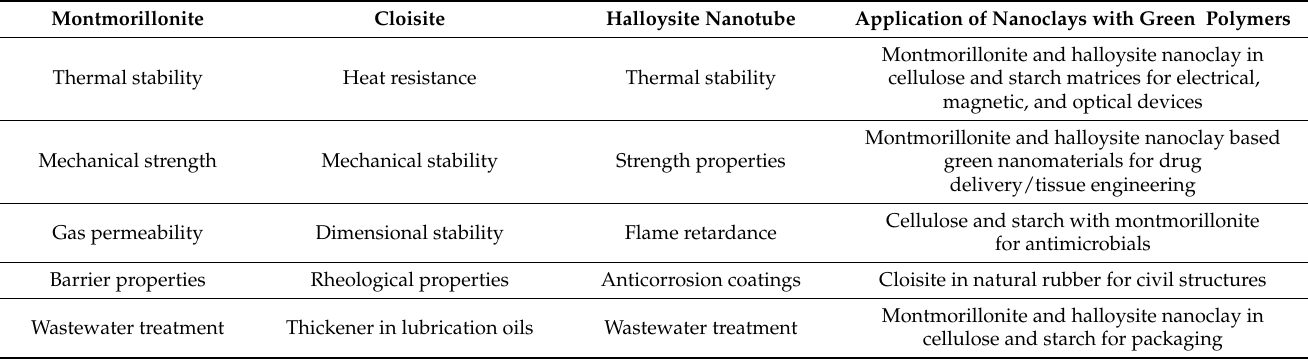
Table 4. Property/application of various nanoclay types with green polymers.